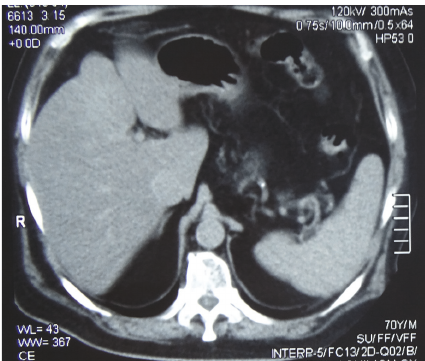
Figure 2: Multi-slice computerized tomography showing no worm even though the ultrasonography showed it.